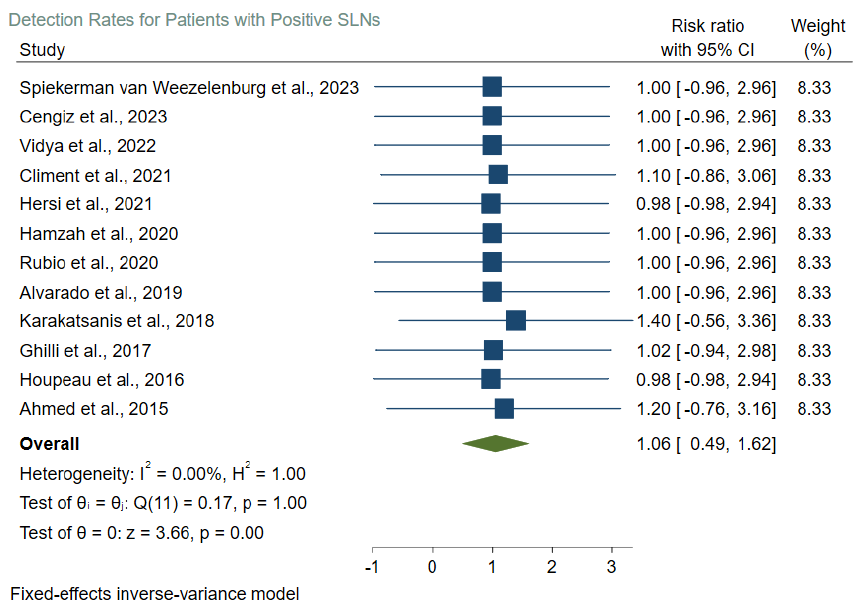
Fig. 4. The forest plot showed patients with positive sentinel lymph node detection rates.